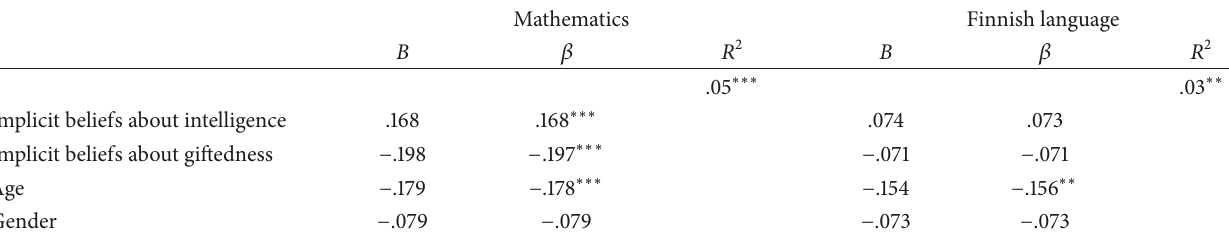
Table 6: Regression analyses for predictors of academic achievement in mathematics and Finnish